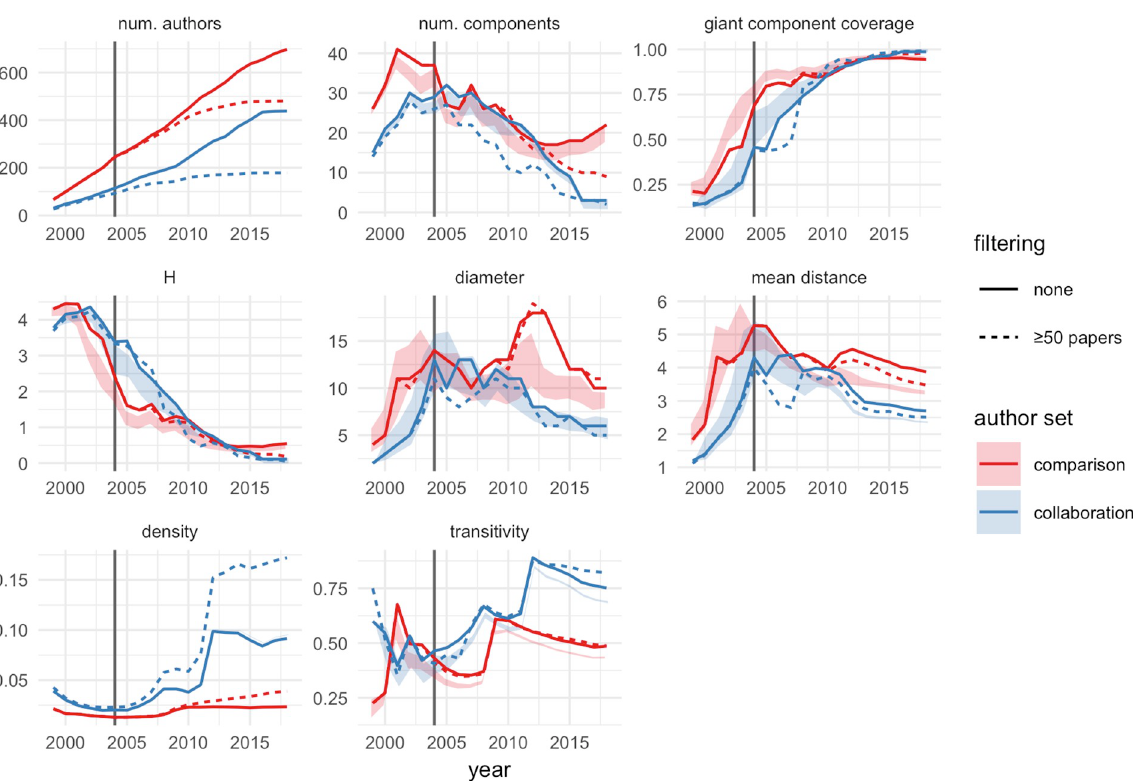
Fig 4. Network statistics over time. See text for explanation of the different statistics calculated here. Solid lines correspond to observed values; shaded ribbons correspond to 90% confidence intervals on rewired networks, where 5% of the observed edges are randomly rewired while maintaining each node’s degree distributions. 100 rewired networks are generated for each author set-year combination. Dashed lines correspond to observed values for authors with 50 or more total papers in the data. Blue corresponds to the MoBE collaboration; red corresponds to the peer comparison set of authors. Vertical lines indicate 2004, the first year of research funding by the MoBE program. Due to publication lags, we would not expect to see effects from 2004 funding until 2006-07.